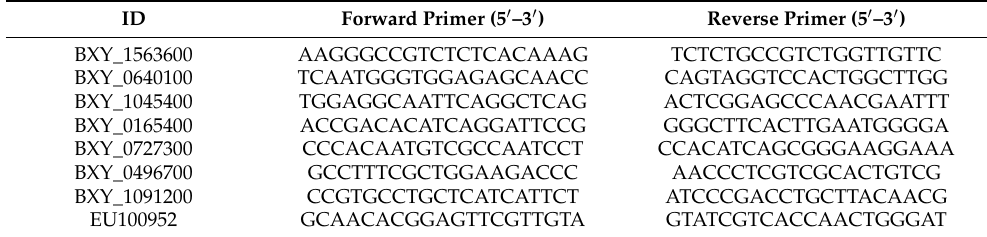
Table 2. The RT–qPCR primers for 8 differentially expressed